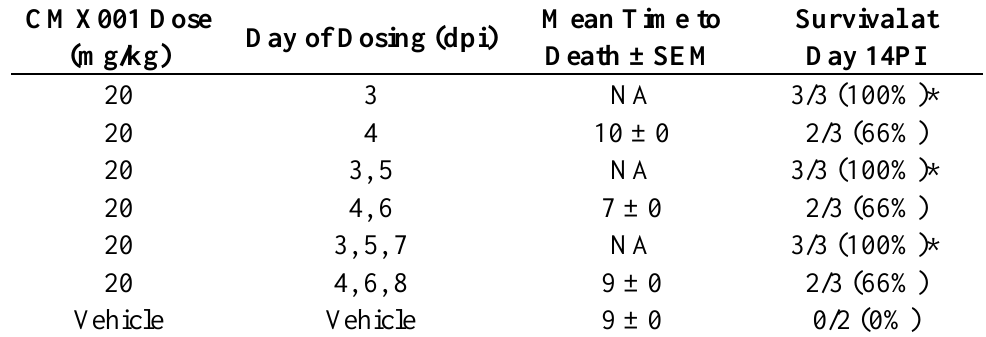
Table 1. Evaluation of 1, 2 or 3 doses of CMX001 given every other day beginning at day 3 or 4 post infection. CMX001 was administered once a day